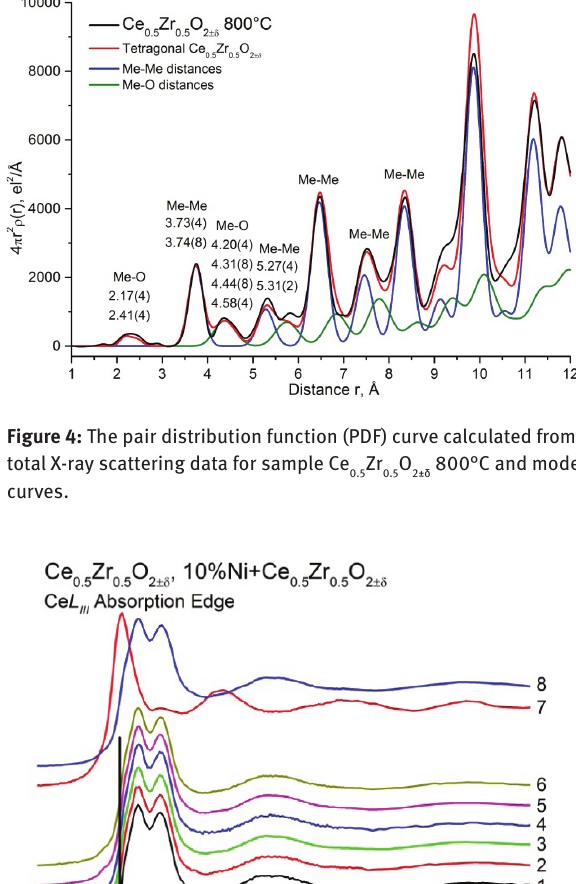
Zr O 600°C; 2 – Ni+Ce 0.5 0.5 2±δ